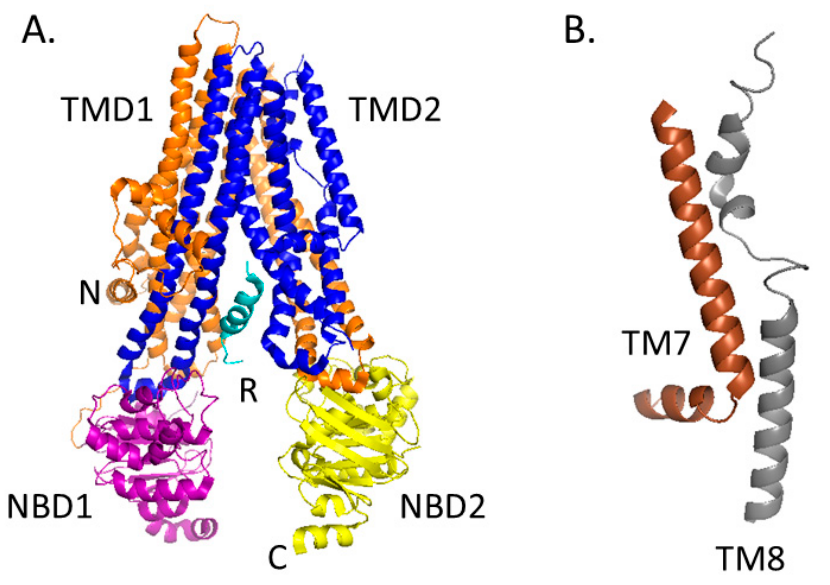
Figure 2. Cryo-EM structure of dephosphorylated, ATP-free CFTR. A. CFTR contains two transmembrane domains (TMD1 in orange, TMD2 in blue), two nucleotide binding domains (NBD1 in purple, NBD2 in yellow), and a regulatory (R) domain (cyan). CFTR is activated by phosphorylation of the R domain and ATP hydrolysis by the NBDs. Note that the structural flexibility of the R domain limits its visibility by Cryo-EM. Instead, 19 alanines are shown that correspond to the C-terminal region of the R domain. B. Magnified view of transmembrane helices (TM) 7 (brown) and 8 (gray). CFTR differs from other ABC transporters in that TM7 is displaced from its usual position and TM8 breaks into three short helices, rather than being a continuous helix as seen in other ABC transporters. TM7 and TM8 are found in TMD2. PBD ID: 5UAK.